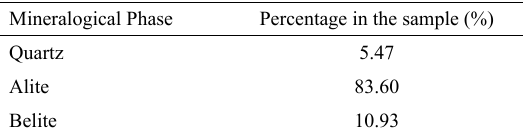
Table 3. Mineralogical composition obtained through the XRD analysis of cement.